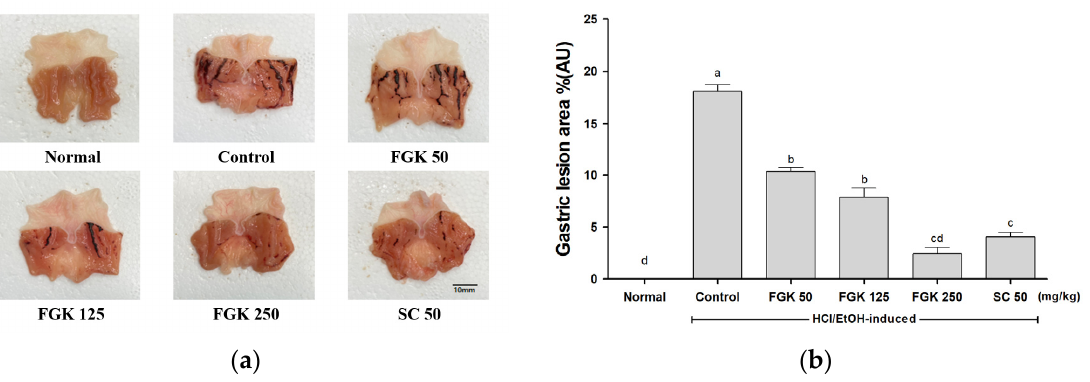
Figure 3. Effects of fermented gold kiwi (FGK) on gastric surface protection in HCl/EtOH-induced gastric injury models. ( a ) Gross appearance of stomach tissues in HCl/EtOH-induced rats; ( b ) ratios of hemorrhagic lesion area to total area; ( c ) size of the ulcers that formed in the gastric mucosa was measured, and the sum of sizes was converted into a macroscopic damage score. Normal, rats treated with only DW; Control, rats treated with HCl/EtOH; SC 50, rats treated with HCl/EtOH and sucralfate; FGK, rats treated with HCl/EtOH and FGK (50, 125, and 250 mg/kg). Results are expressed as mean ± SEM (N = 8). a–d Different labels were significantly different at p < 0.05 between treatments, as determined by Tukey’s analysis.